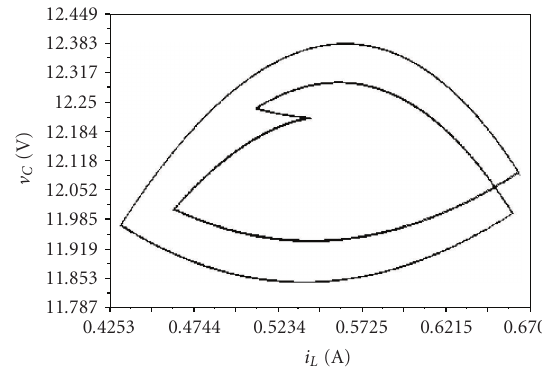
Figure 7: 2- T subharmonic operation. ( E = 37 . 5 V): time waveform of the capacitor voltage.